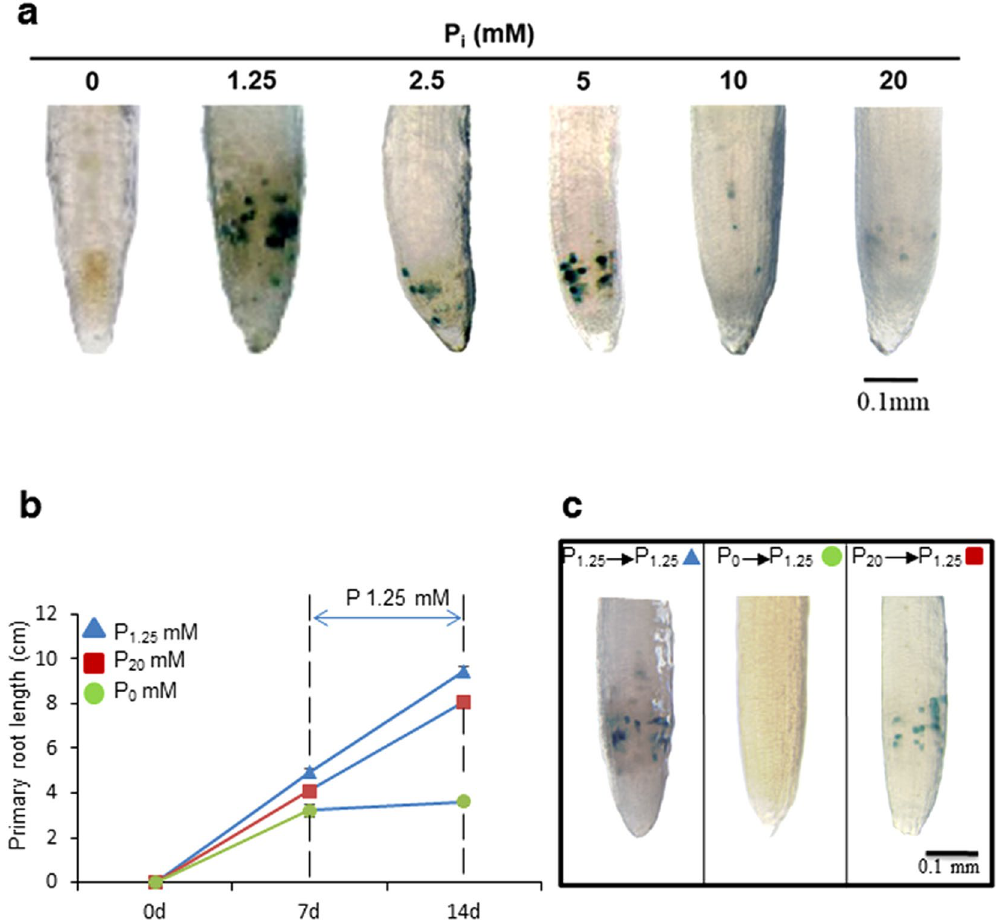
Figure 4. Excess P i treatment attenuates the meristematic activity of primary root indeterminately. Histochemical GUS staining of primary root tips of CycB1 ; 1:uidA transgenic seedlings grown as described in the legend to Fig. 1 ( a ). WT Arabidopsis seedlings were grown on P 1.25 , P 0 , and P 20 media for 7 days as described earlier, thereafter replenished with P 1.25 media and growth monitored after 7 days ( b ). A similar experiment was performed with transgenic seedlings of CycB1;1:uidA and documented for histochemical GUS staining ( c ). Pictures are representative of 10–12 seedlings. Values are means ± SE; n = 21 ( b